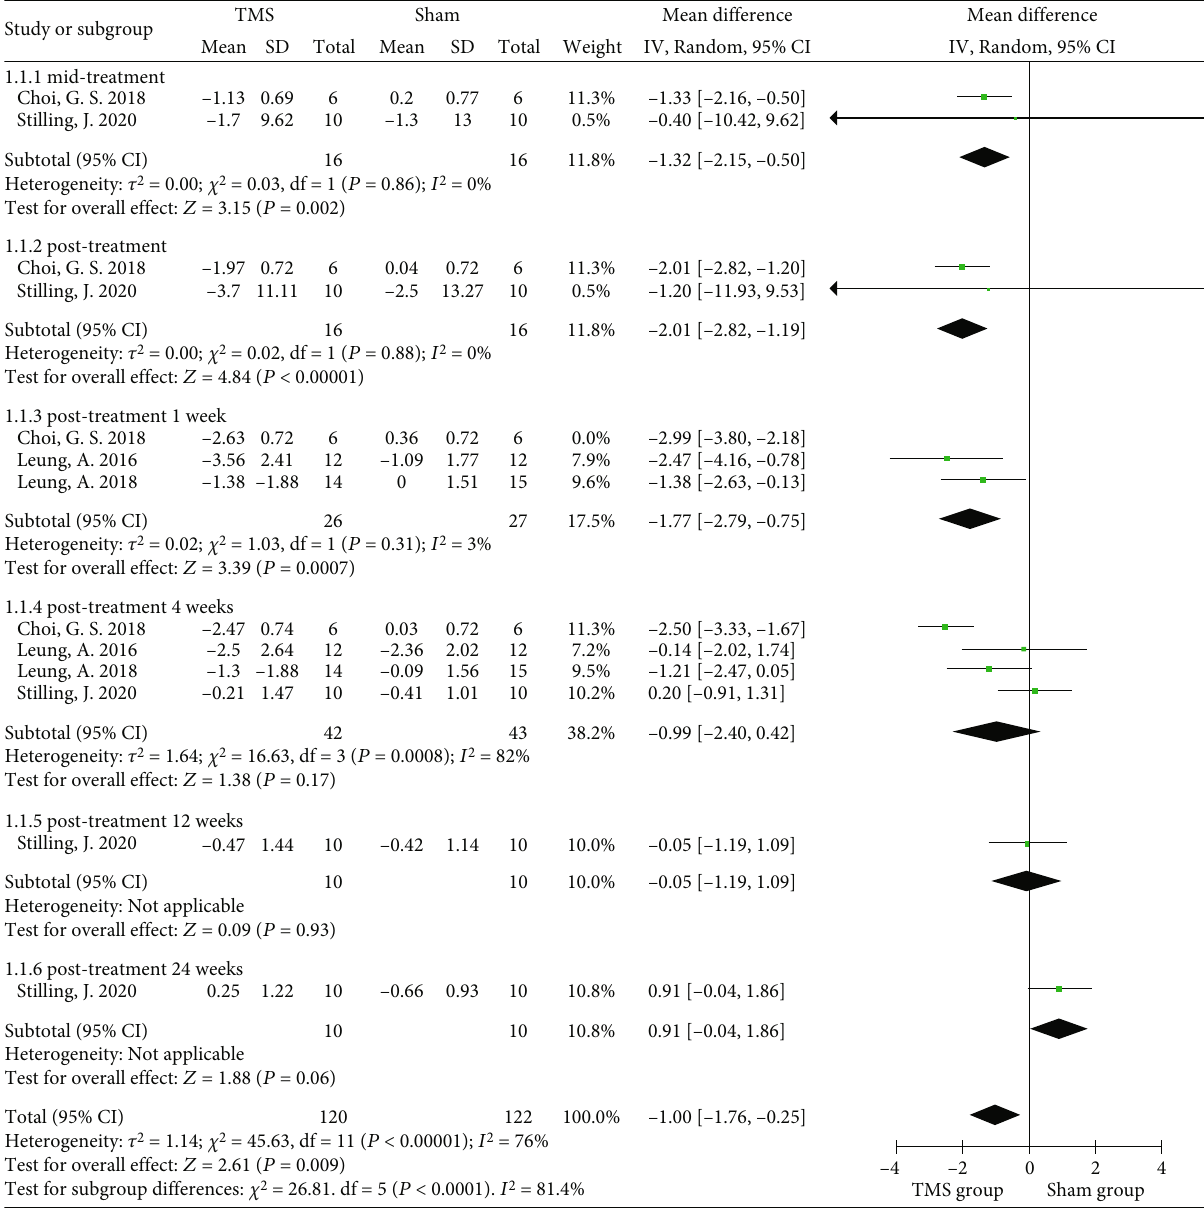
Figure 2: Forest plots of the di ff erent-term e ff ects of rTMS on self-reported neuropathic pain in